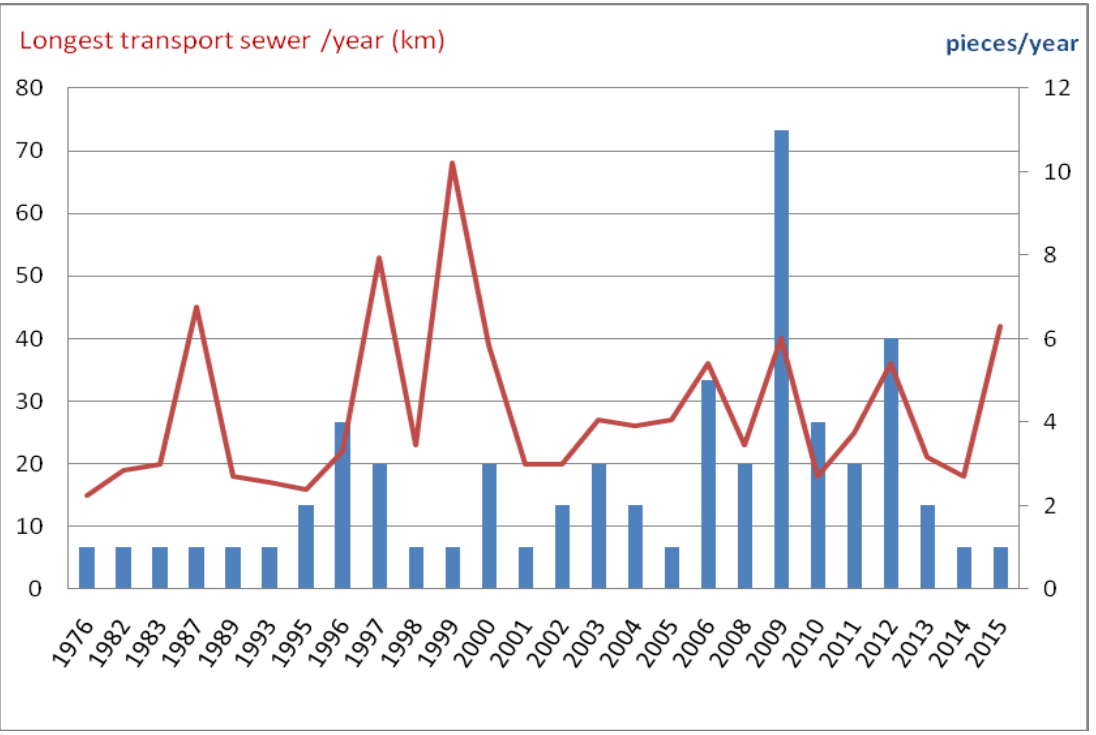
Figure 5. Number of supra-municipal transfer sewers over 15 km constructed and the longest constructed each year